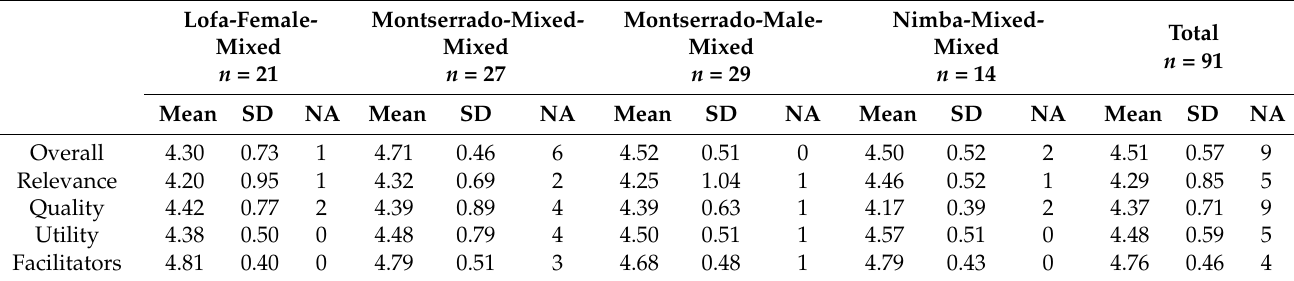
Table 3. Satisfaction of trainees regarding the